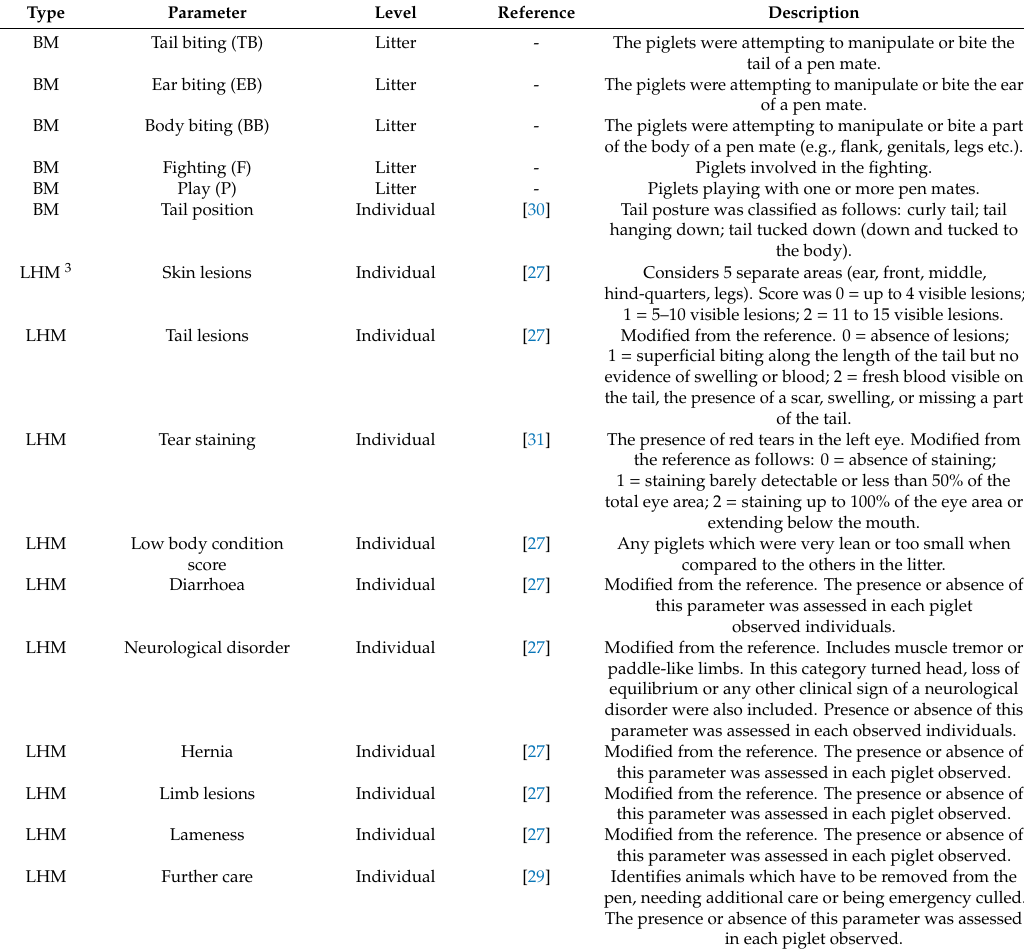
The piglets were attempting to manipulate or bite the tail of a pen mate. The piglets were attempting to manipulate or bite the ear of a pen mate. - The piglets were attempting to manipulate or bite a part of the body of a pen mate (e.g., flank, genitals, legs etc.). - Piglets involved in the fighting.